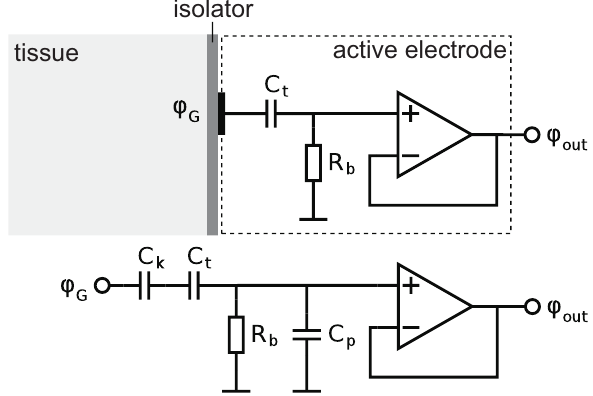
Fig.2: Measuring arrangement for impedance measurement with two or four electrodes and the corresponding equivalent electric